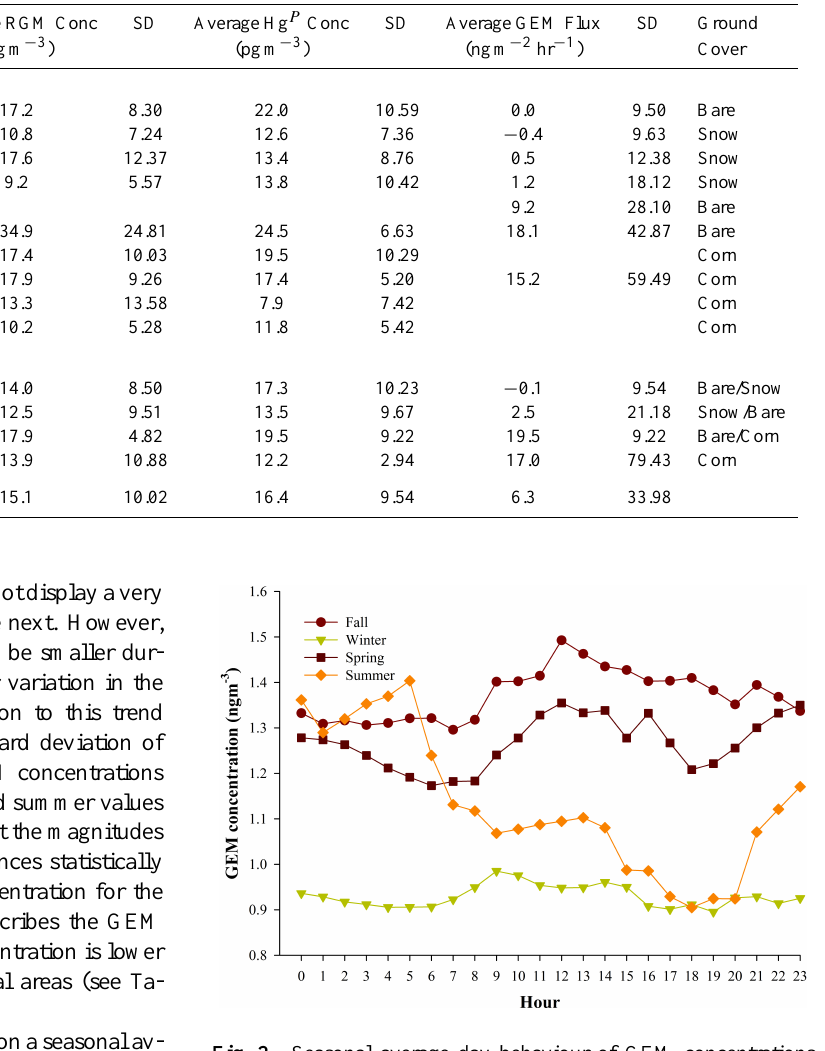
Fig. 2. Seasonal average day behaviour of GEM concentrations (ngm − 3 ) measured during the study at Elora Research Station, ON (1 November 2006 to 29 June